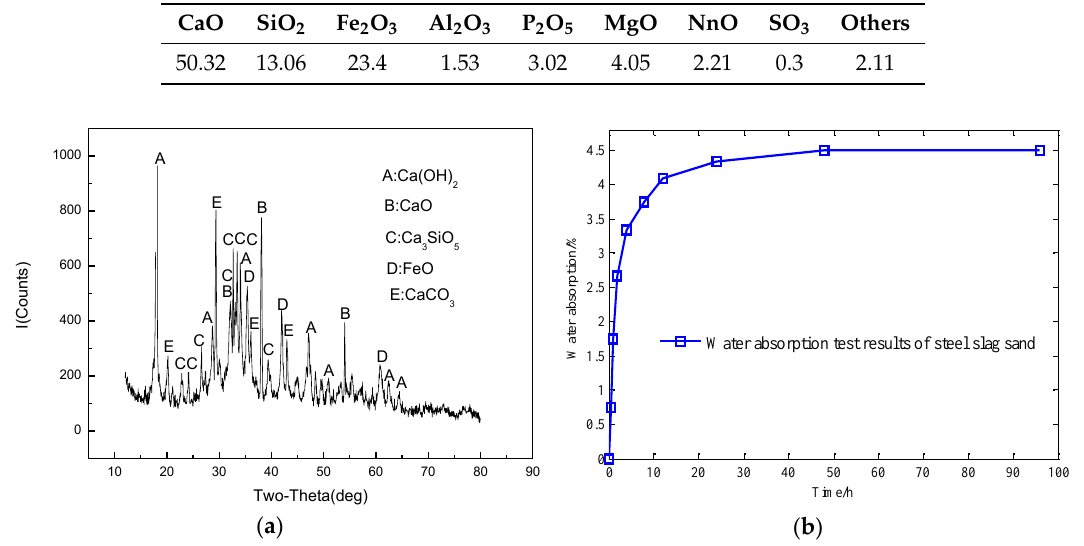
Figure 2. X-ray diffraction (XRD) and water absorption experimental results of steel slag used as fine aggregates in self compaction concrete: ( a ) XRD test results; ( b ) water absorption.